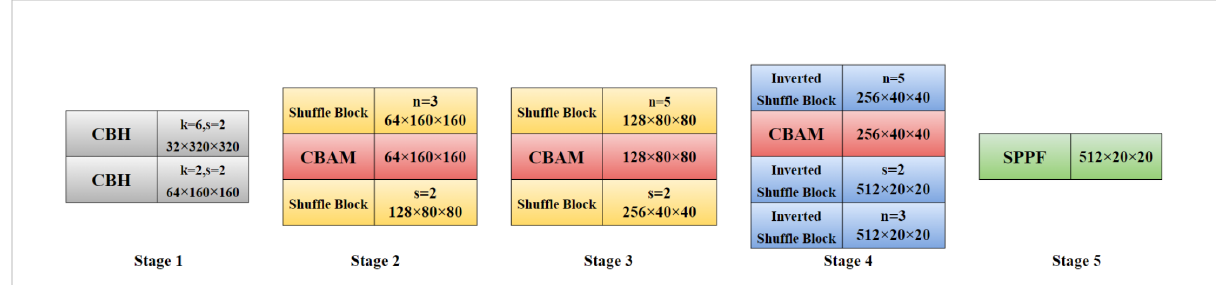
FIGURE 2 YOLO-P ’ s backbone. k is convolutional kernel size, s is stride, and n is the number of module ’ s repetitions. Unspeci fi ed k is 3, s is 1, and n is